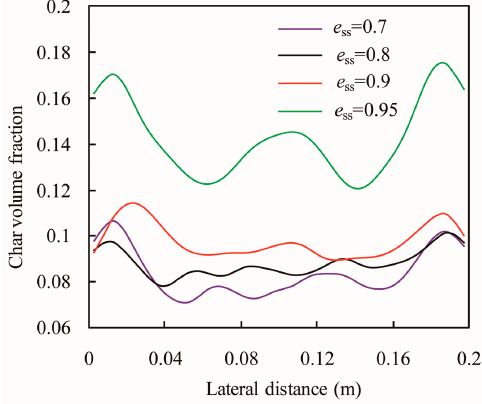
Figure 14. Lateral profiles of the time-averaged particle volume fraction of the flotsam at Z = 0.153 m.